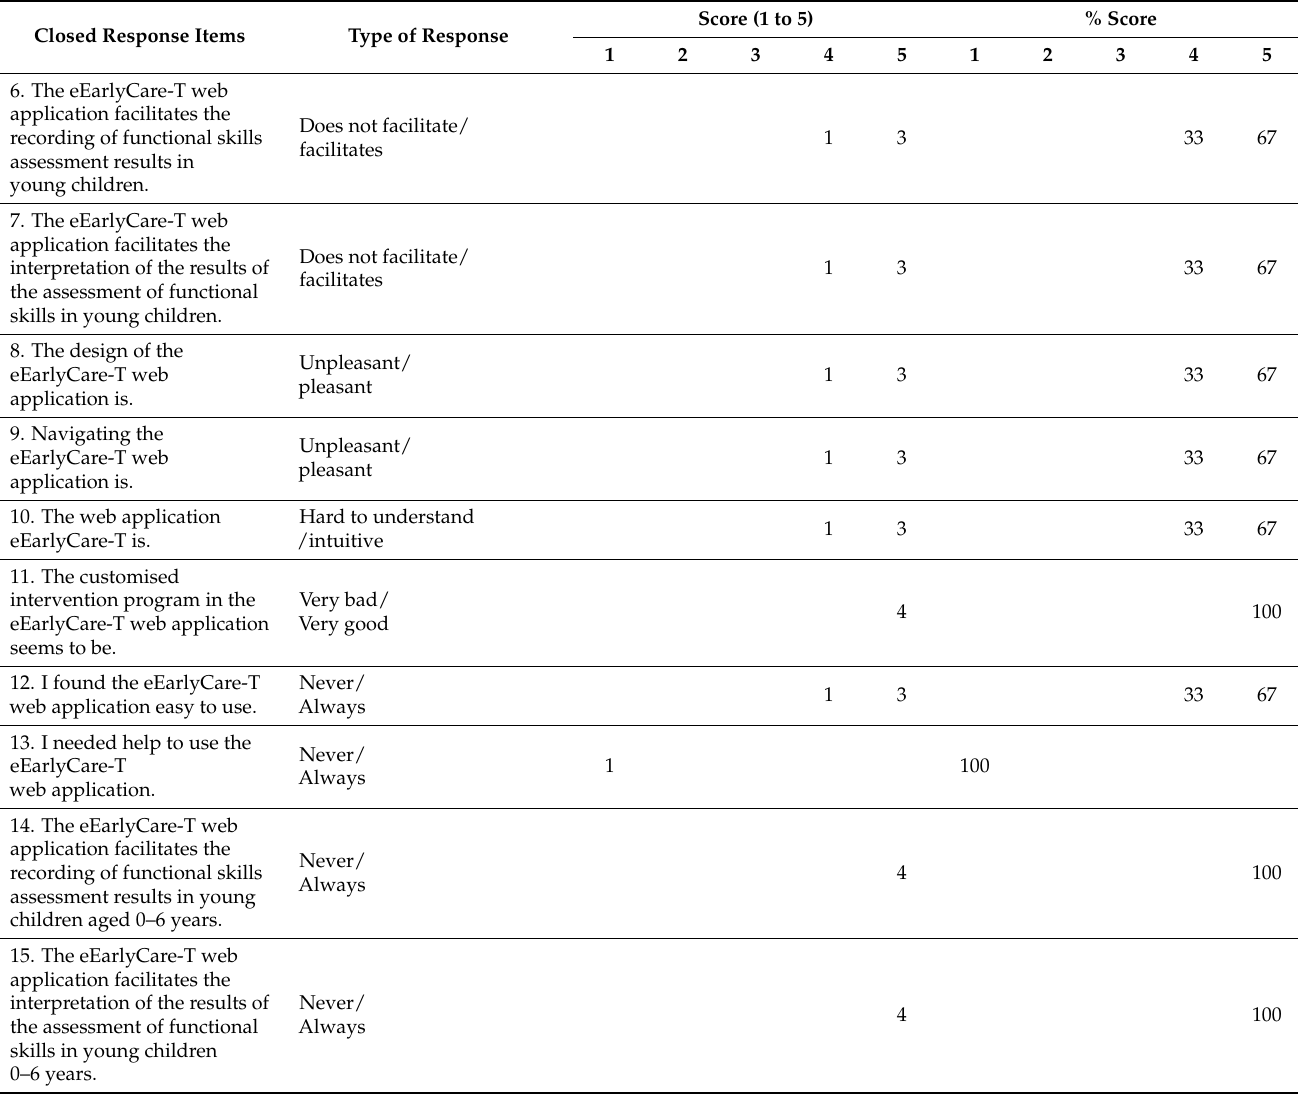
Table 2. Closed response items from the usability